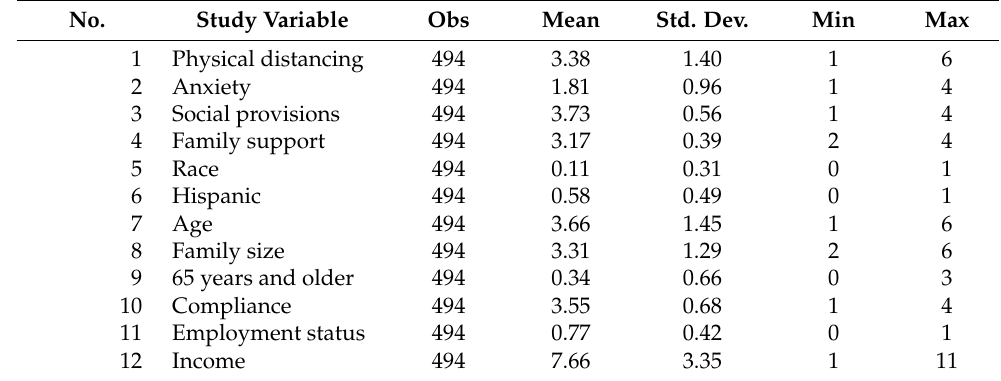
Table A5. Summary of Study